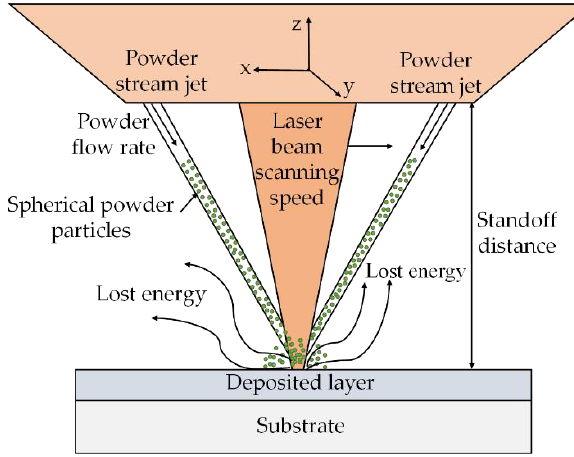
Figure 2. Schematic diagram of the LMD process; based on the data provided in Ref. [5,51].